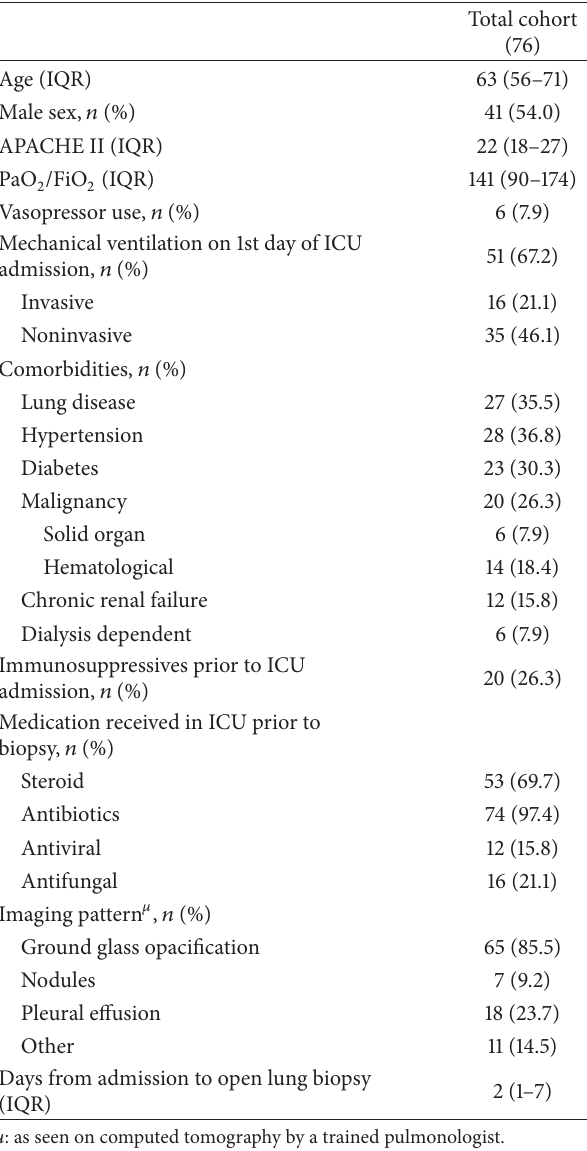
Table 1: Baseline clinical characteristics of cohort of patients who underwent an open lung biopsy.